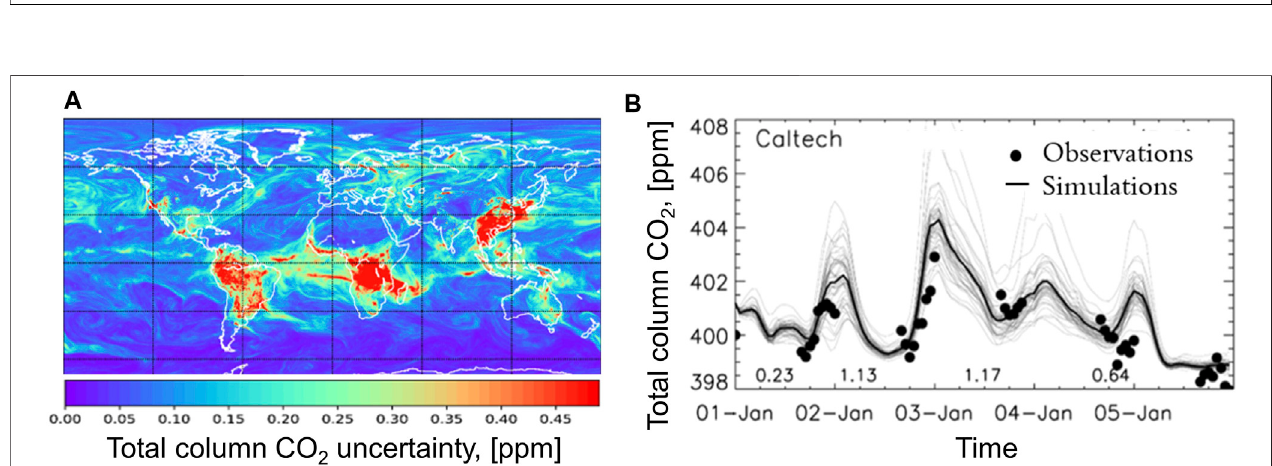
FIGURE 7 | Total column CO 2 global model error from a 50-member IFS ensemble (A) accounting for uncertainties in meteorological initial conditions, model physics, anthropogenic emissions and the biogenic feedback after a 10-days simulation in January 2015, and (B) illustration of the CO 2 ensemble spread at Caltech, United States compared with Total Carbon Column Observing Network (TCCON) observations with grey thin lines represents each of the single ensemble member simulations, from McNorton et al. (2020).